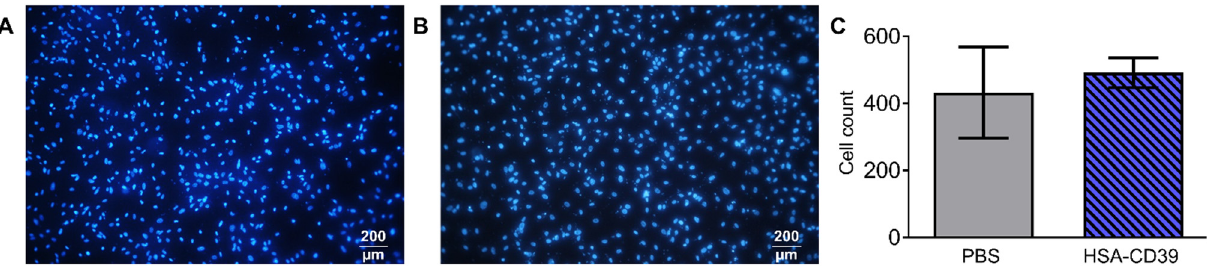
Figure 6. HSA-CD39 coated onto nitinol BlueOxide plates has no negative impact on endothelialisation. Incubation of HSA-CD39-coated nitinol BlueOxide stents with hECs. Analysis performed after 48 h with DAPI staining under epifluorescence microscopy. ( A ) Blank plate incubated with hECs. ( B ) HSA-CD39-coated plate incubated with hECs. ( C ) Quantitative analysis of coated (HSA-CD39) and uncoated (PBS control) plates. Original magnification: 10 × . Values of at least 3 independent experiments are depicted.